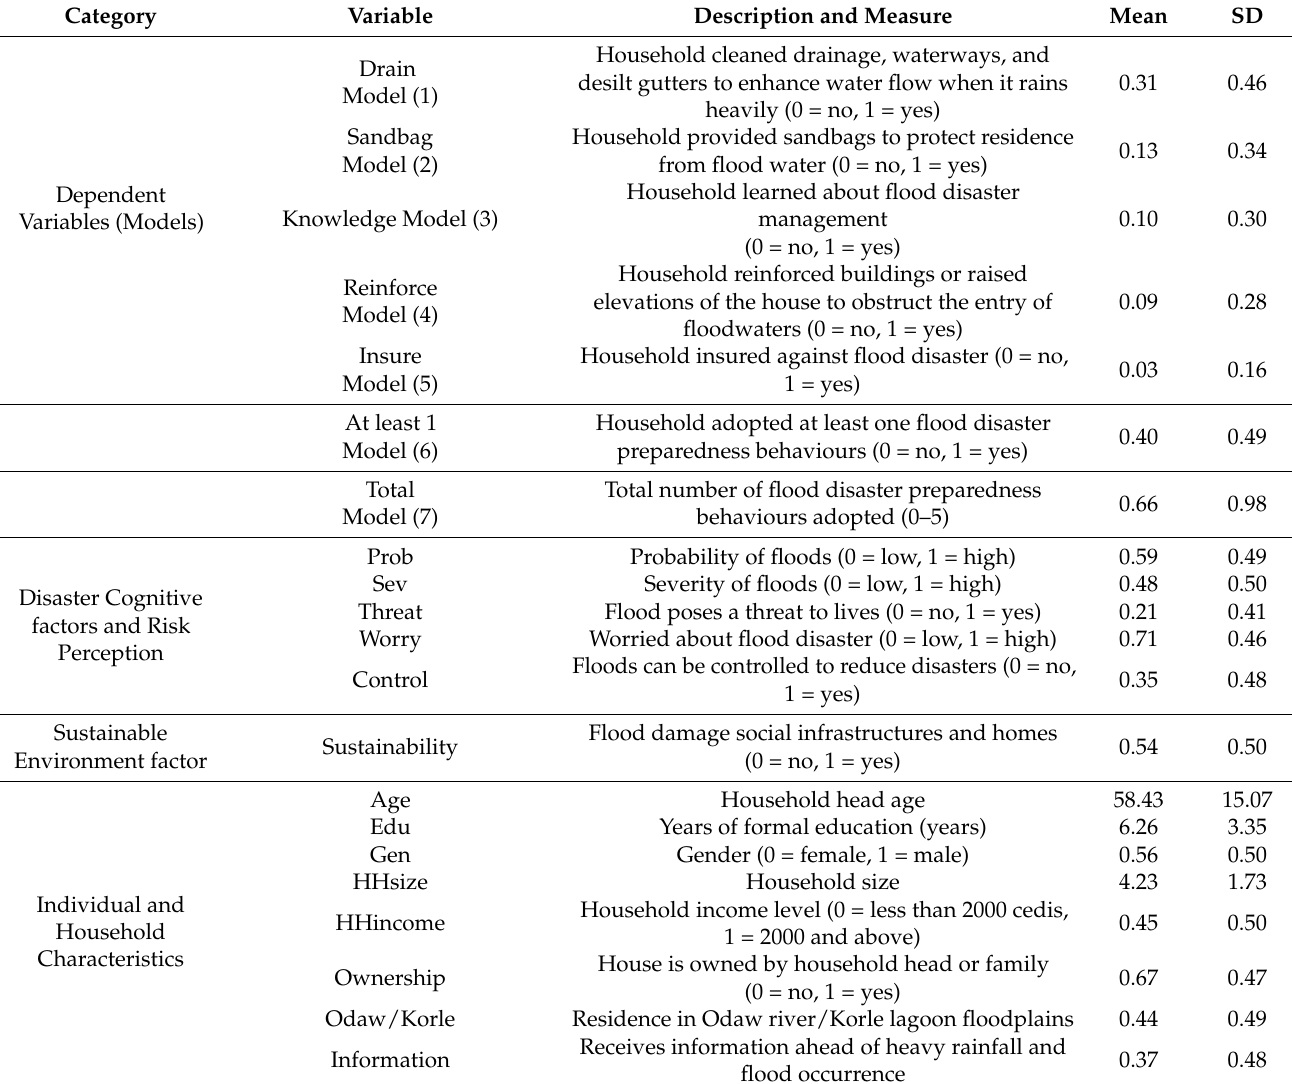
Table 3. Definition and descriptive statistics of the variables used in the